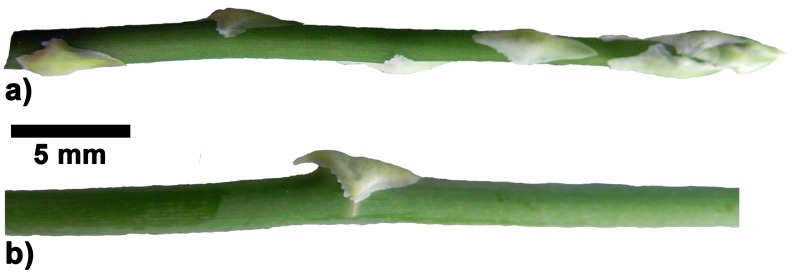
Morphology of axes and spines in Asparagus setaceus.a) shoot tip with young, not yet fully developed spines, b) middle segment with fully differentiated spine.